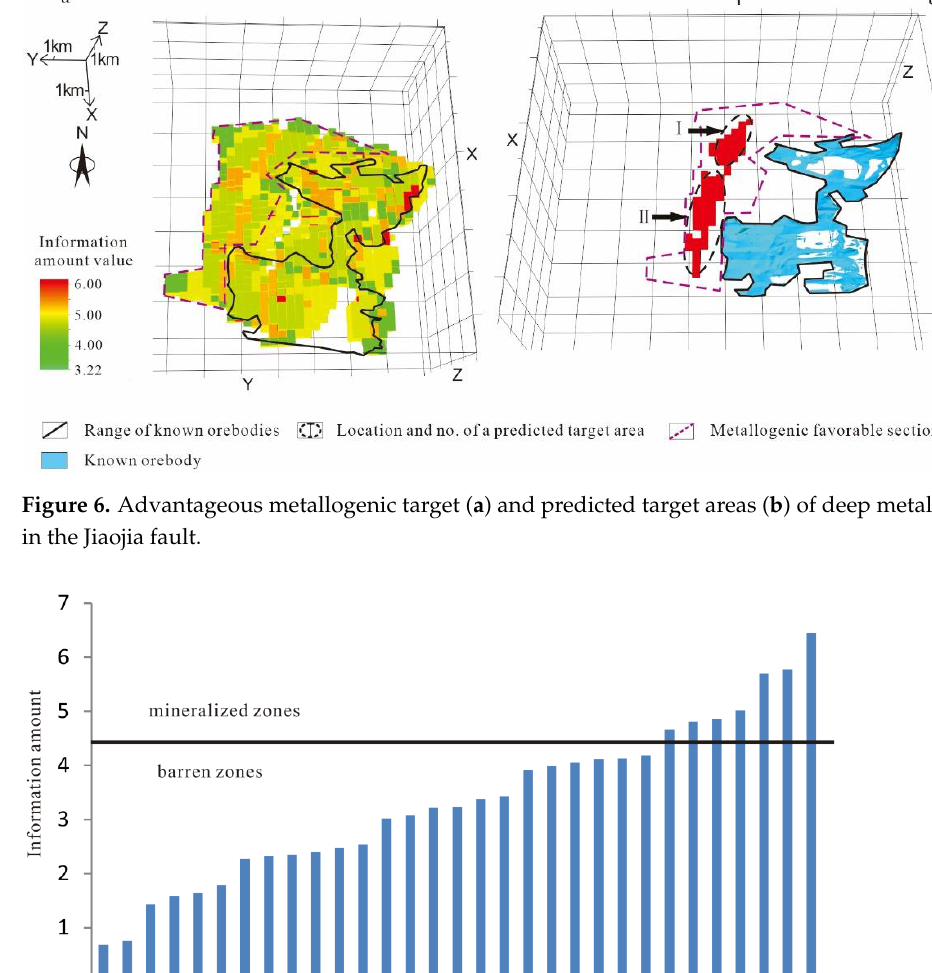
Figure 7. Histogram of metallogenic information amount showing the mineralized zones and the barren zones in the Jiaojia fault.